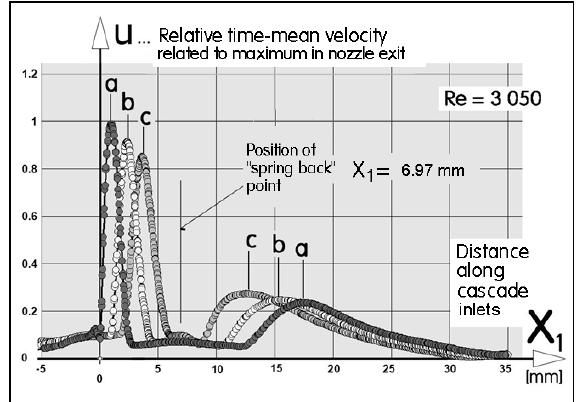
Fig. 14. Typical photograph of the measurements of the refraction angle  Z . The exit air flow was followed by two cotton threads with their upstream ends fixed to the cascade.